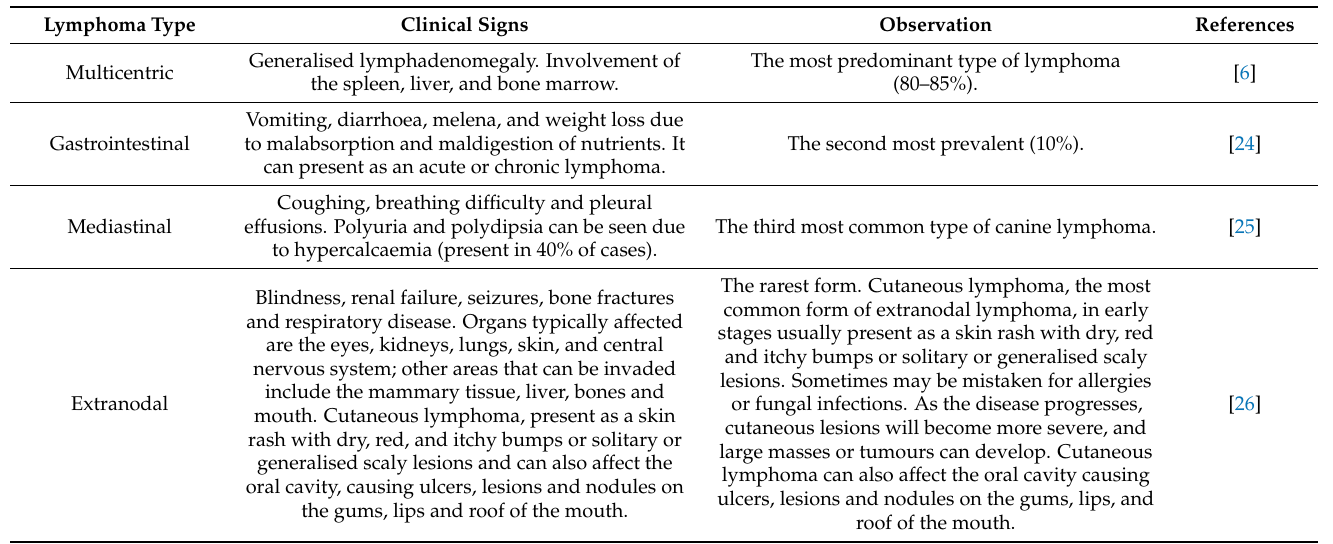
Table 1. Common clinical manifestations according to the type and presentation of the